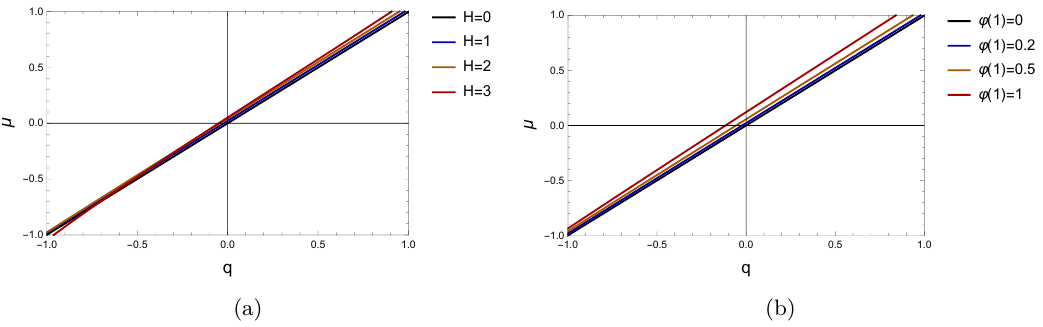
Figure 6 . (a) Charge density dependence of chemical potential for different external magnetic field with ϕ (1) = 0 . 2 and β = 0 . 33 . (b) Charge density dependence of chemical potential for different condensation with β = 0 . 33 and H = 1